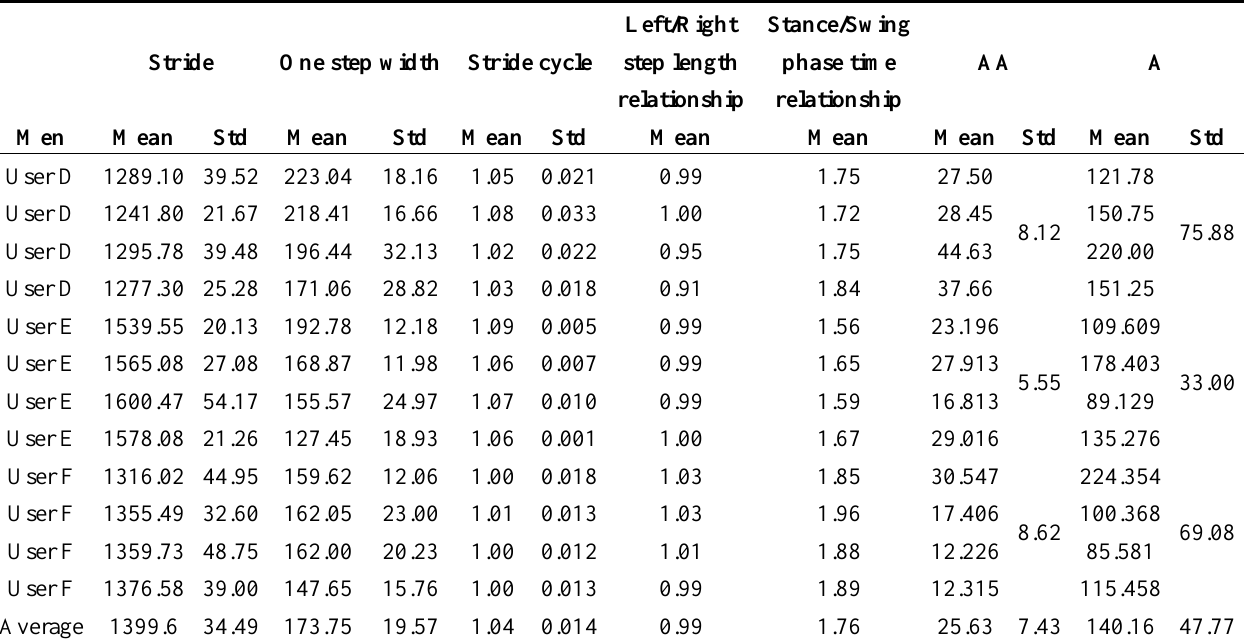
Table 2. Gait parameters of three